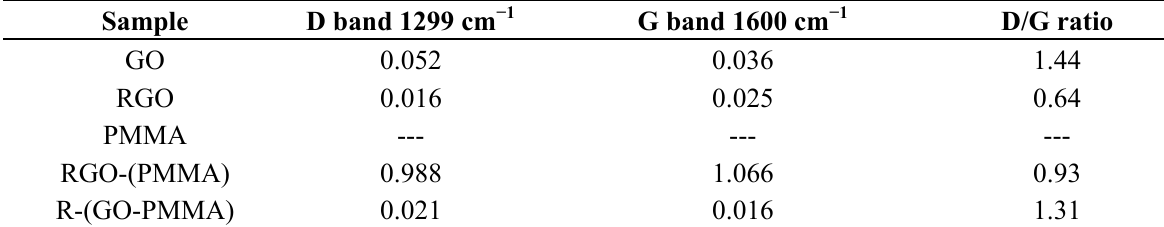
Table 1. Summary of the D/G ratio determined from the Raman